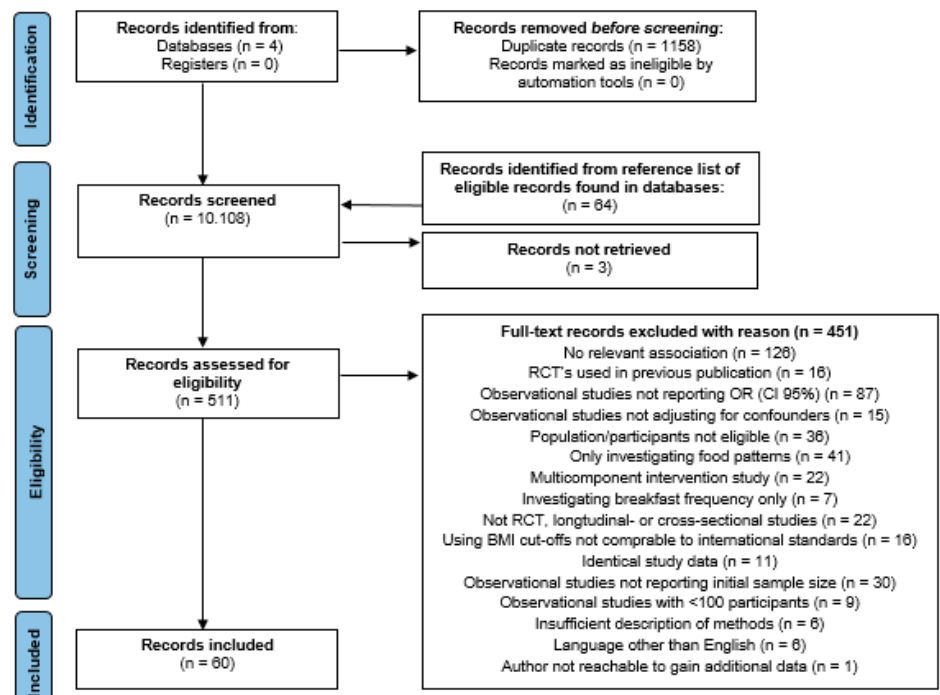
Figure 1. Study selection process.